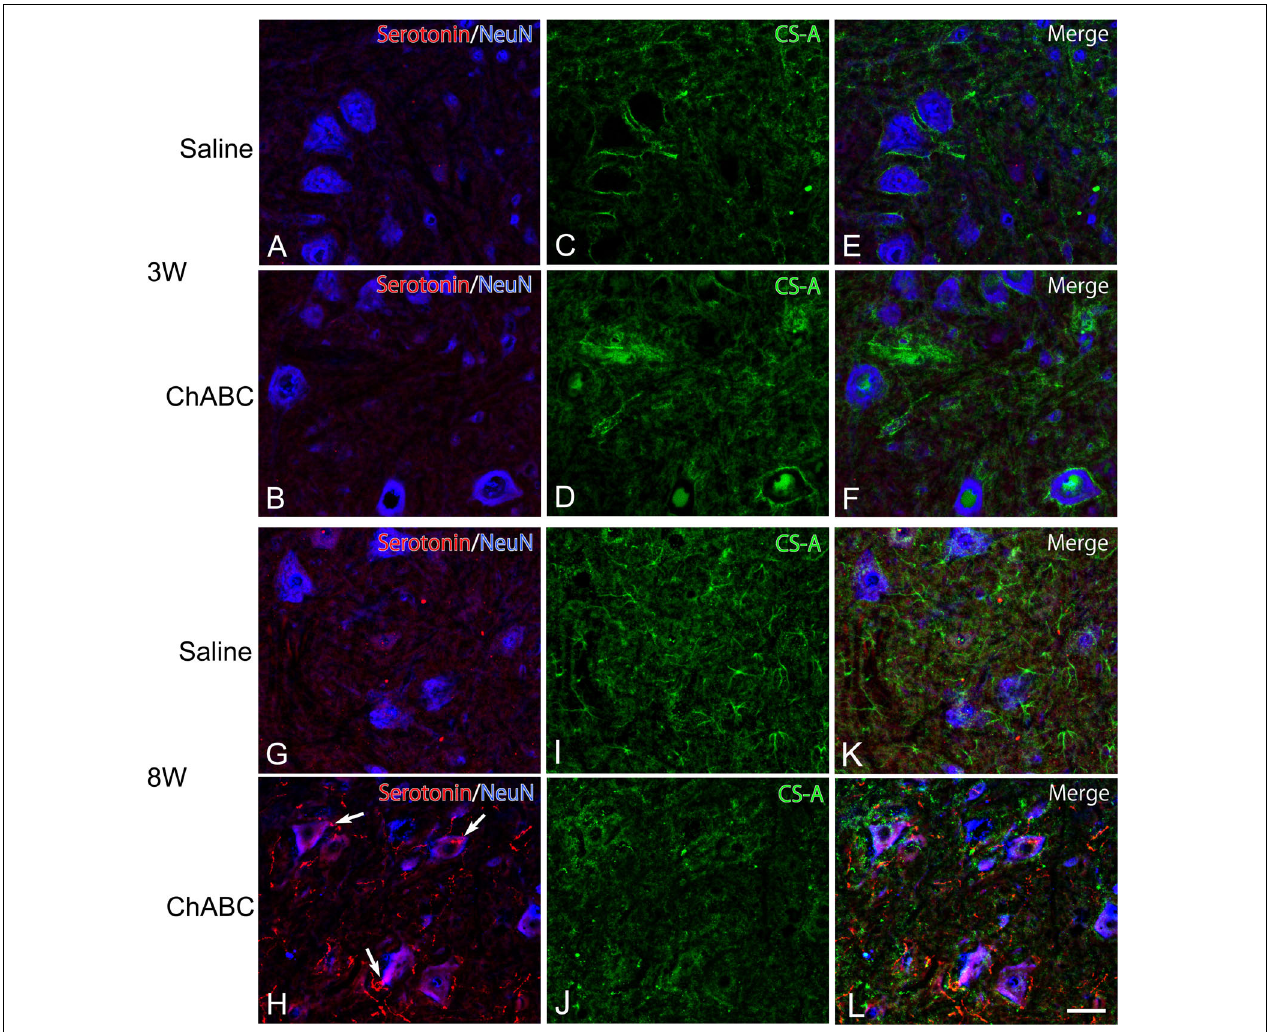
FIGURE 4 | Images of immunohistochemistry for CS-A (green), Neu N (converted to blue), and 5-HT (red) in the L5 ventral horn of rats with saline (A,C,E,G,I,K) , and ChABC (B,D,F,H,J,L) administration at 3 (A–F) , and 8 (G–L) weeks after CST. Double-labeled images of 5-HT and NeuN (A,B,G,H) , CS-A immunohistochemistry images (C,D,I,J) , and merged images (E,F,K,L) are shown. Arrows in (H) indicate 5-HT nerve terminals on NeuN-positive motoneurons. Many 5-HT varicosities were also observed in (H,L) . Scale bars = 50 µ m.